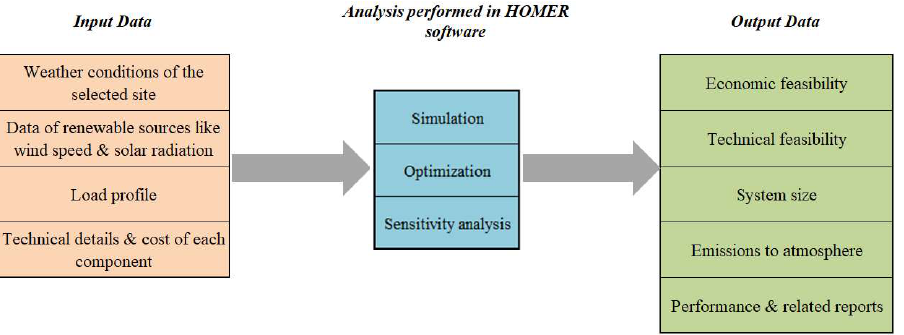
Figure 8. Flow chart of HOMER software tool.